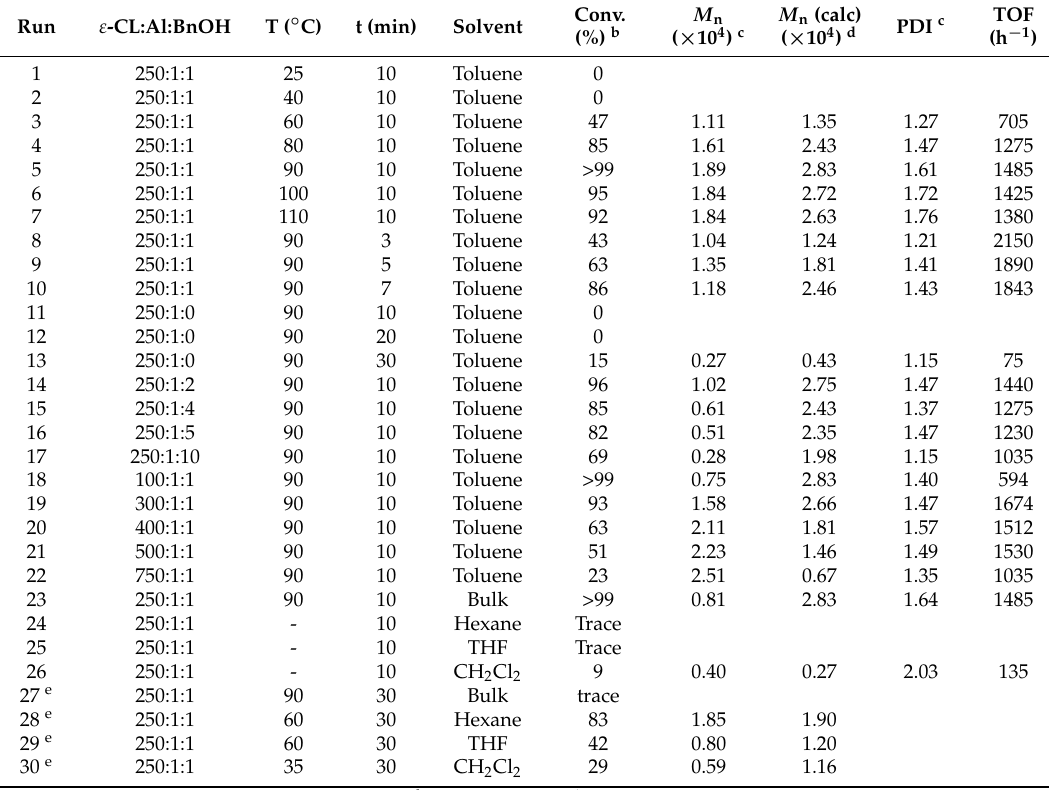
Table 4. The ROP of ε -CL using C1 a